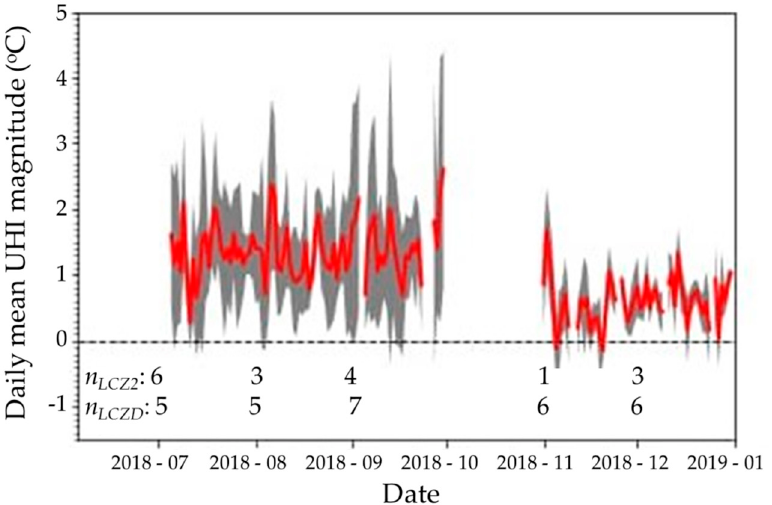
Figure 8. The daily mean urban heat island magnitude (defined as TLCZ2–TLCZD), indicated by the red line. n LCZ2 and n LCZD represent the most common number of stations for that month in LCZ 2 and LCZ D, respectively. The filled grey area shows the area between the mean plus one standard deviation and the mean minus one standard deviation.